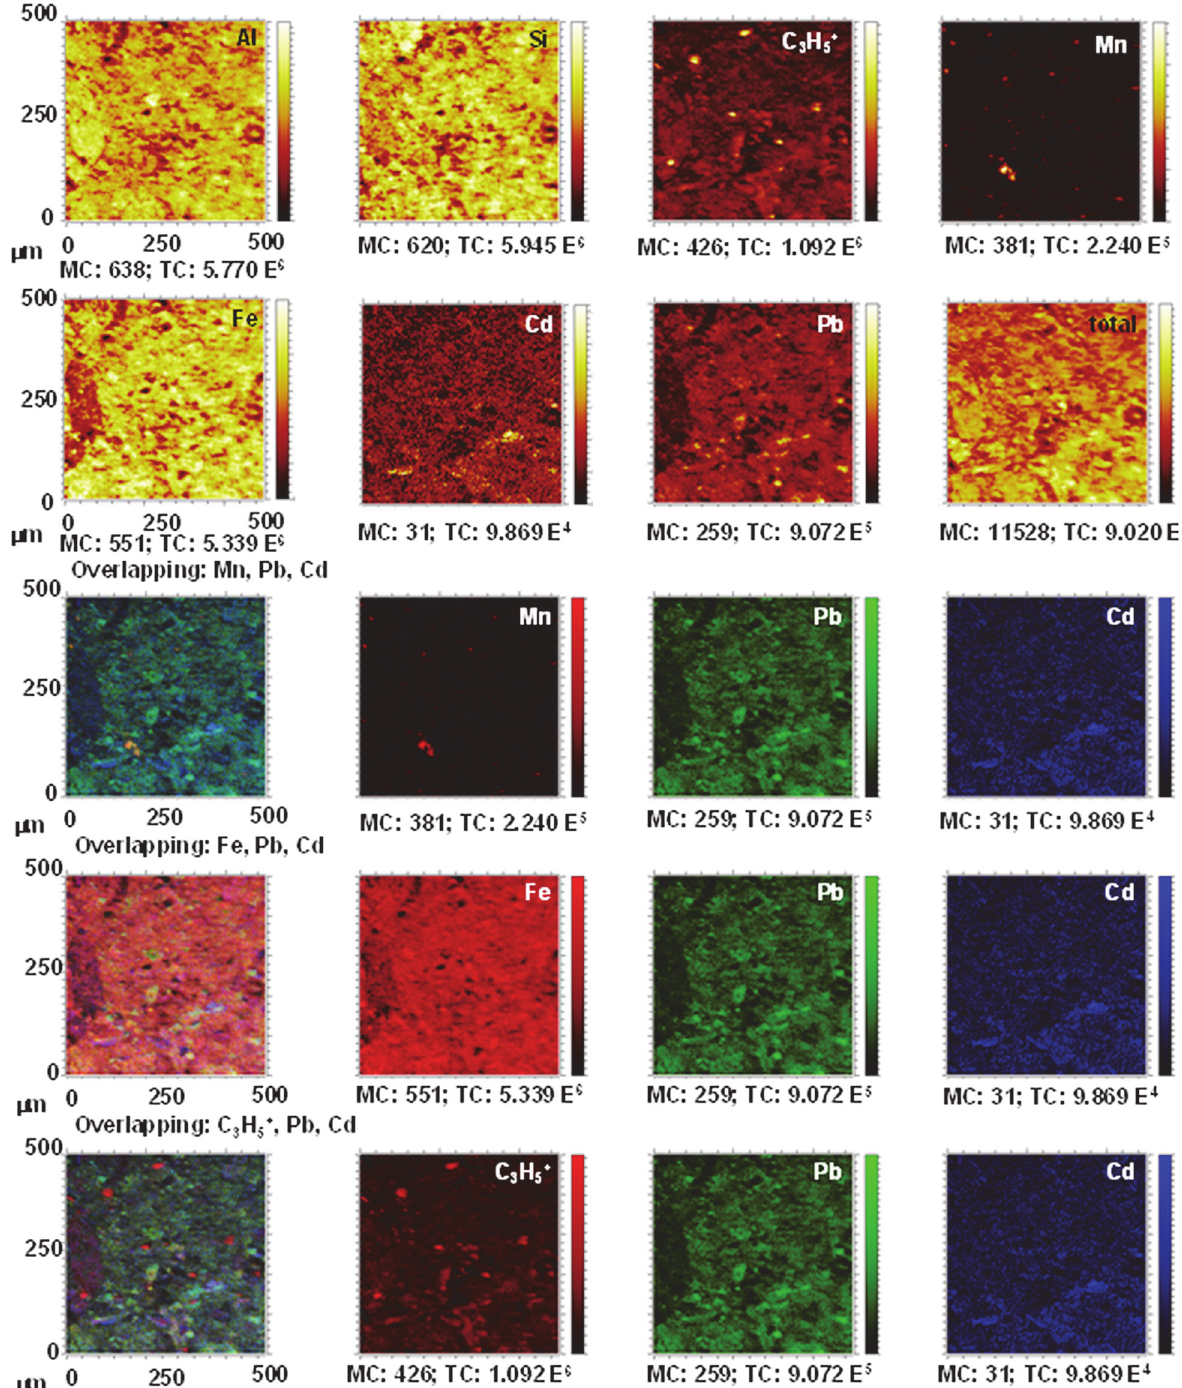
Fig 6. EL.Bt treated with Pb 2+ and Cd 2+ . TOF-SIMS images of Al, C 3 H 5+ , Si, Fe and Mn ions, and overlapping all the signals with Pb 2+ and Cd 2+ . Images of overlapping: Mn + Pb + Cd; Fe + Pb + Cd; and C 3 H 5+ + Pb + Cd showing the concordance between signals.